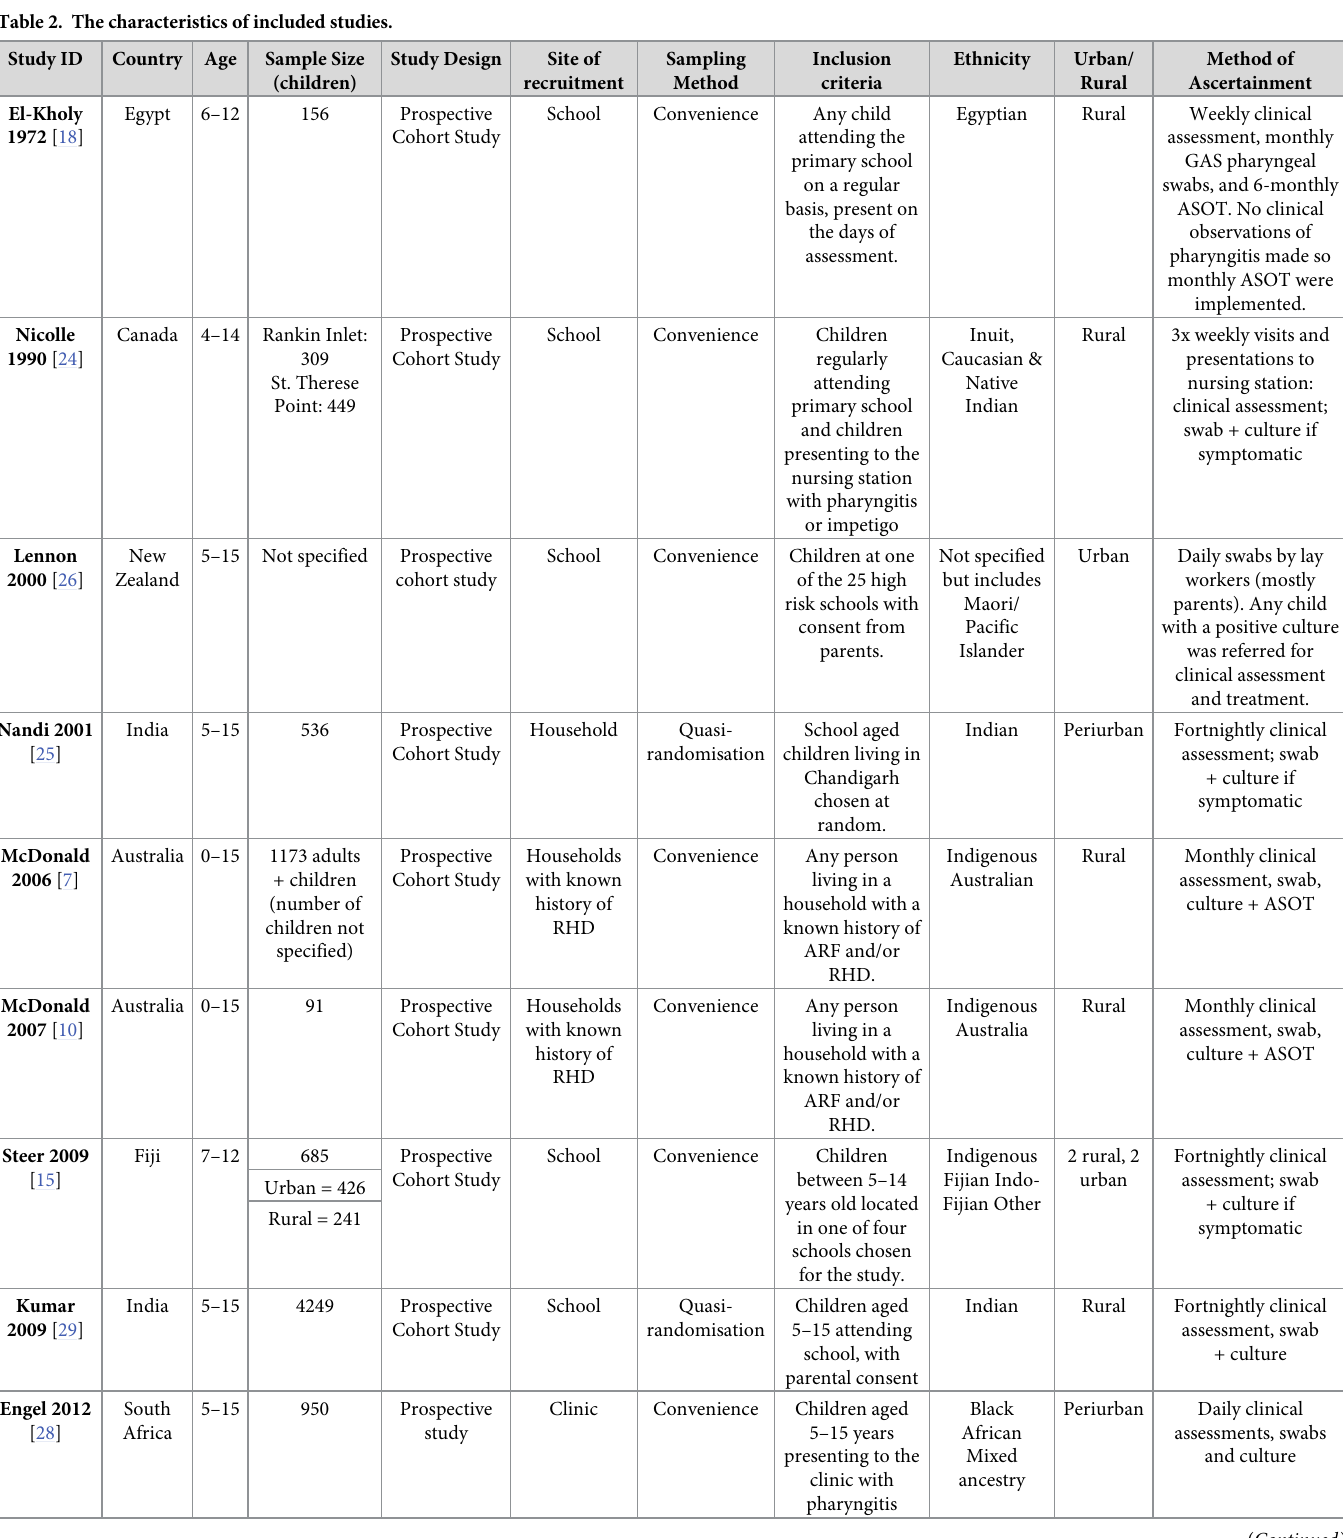
Table 2. The characteristics of included